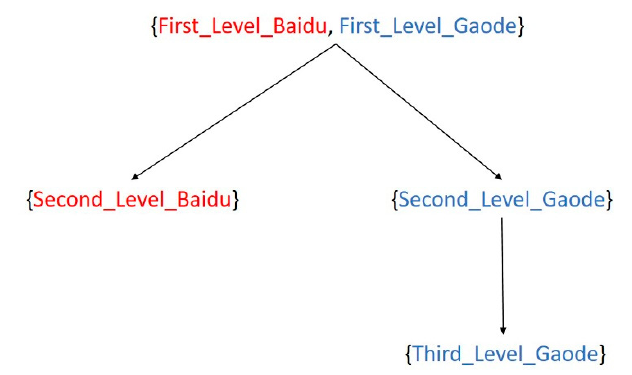
Figure 3. The map of fusion category for di ff erent taxonomies (Baidu Map in red and Gaode Map in blue).